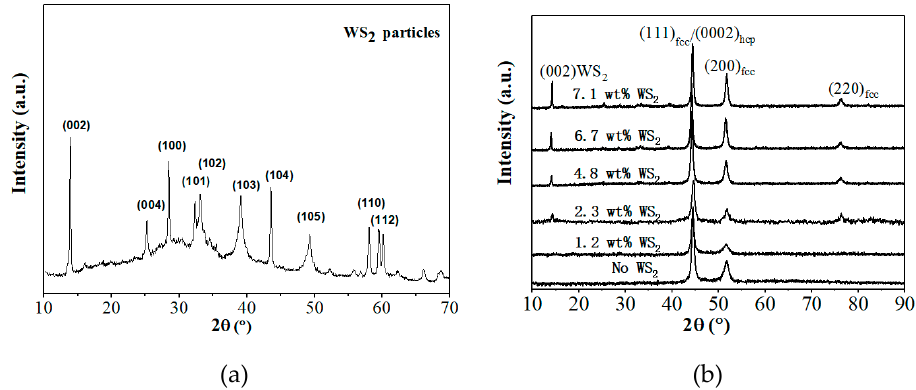
Figure 3. SEM images of the Ni-Co/WS 2 coatings deposited from solutions having controlled WS 2